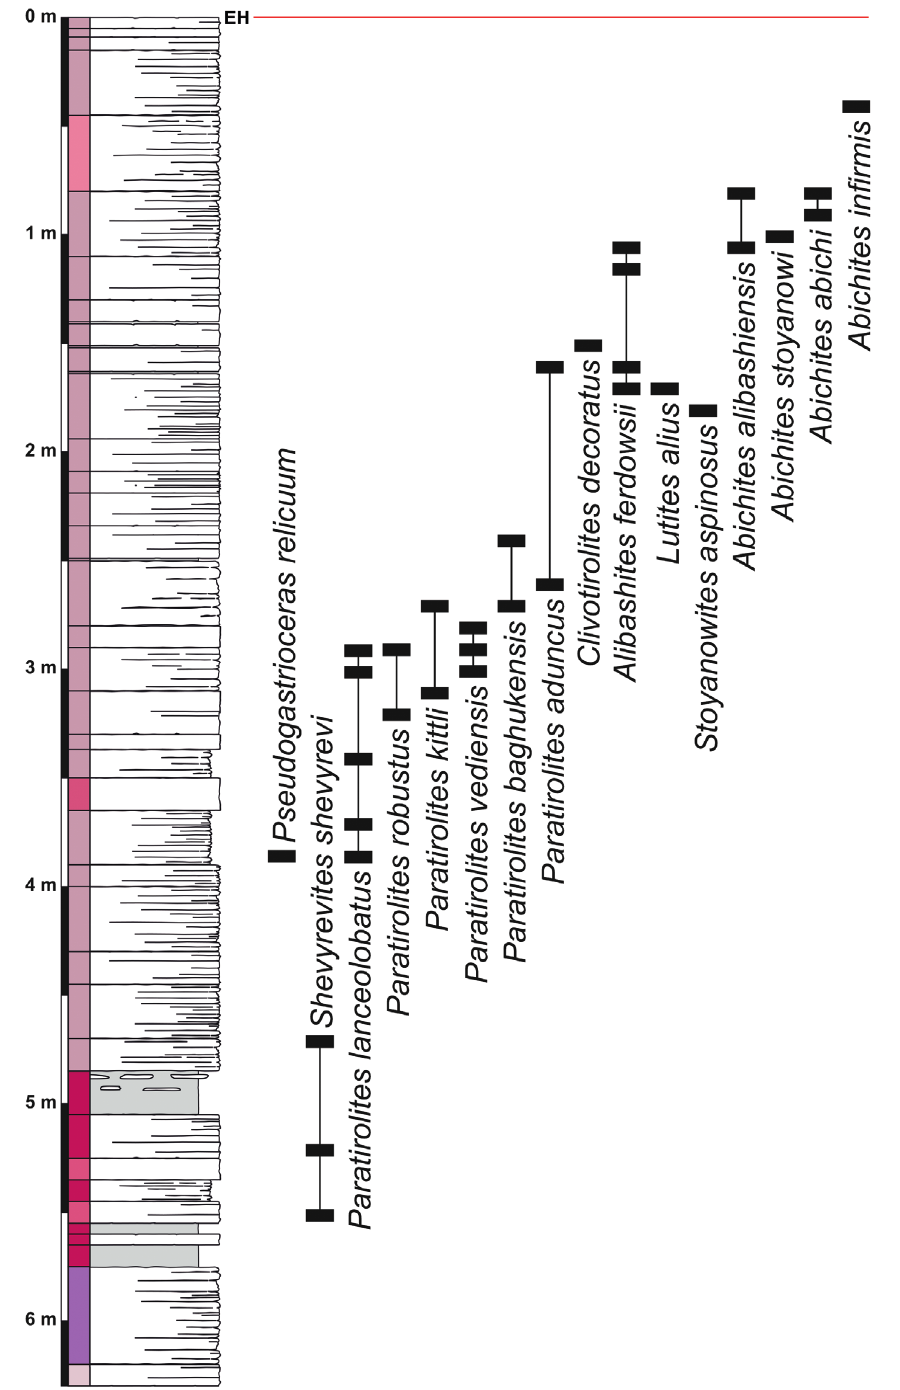
Fig. 5. The stratigraphic occurrence of the ammonoid species in the upper part of the Hambast Formation at Baghuk Mountain 1 section. EH = extinction